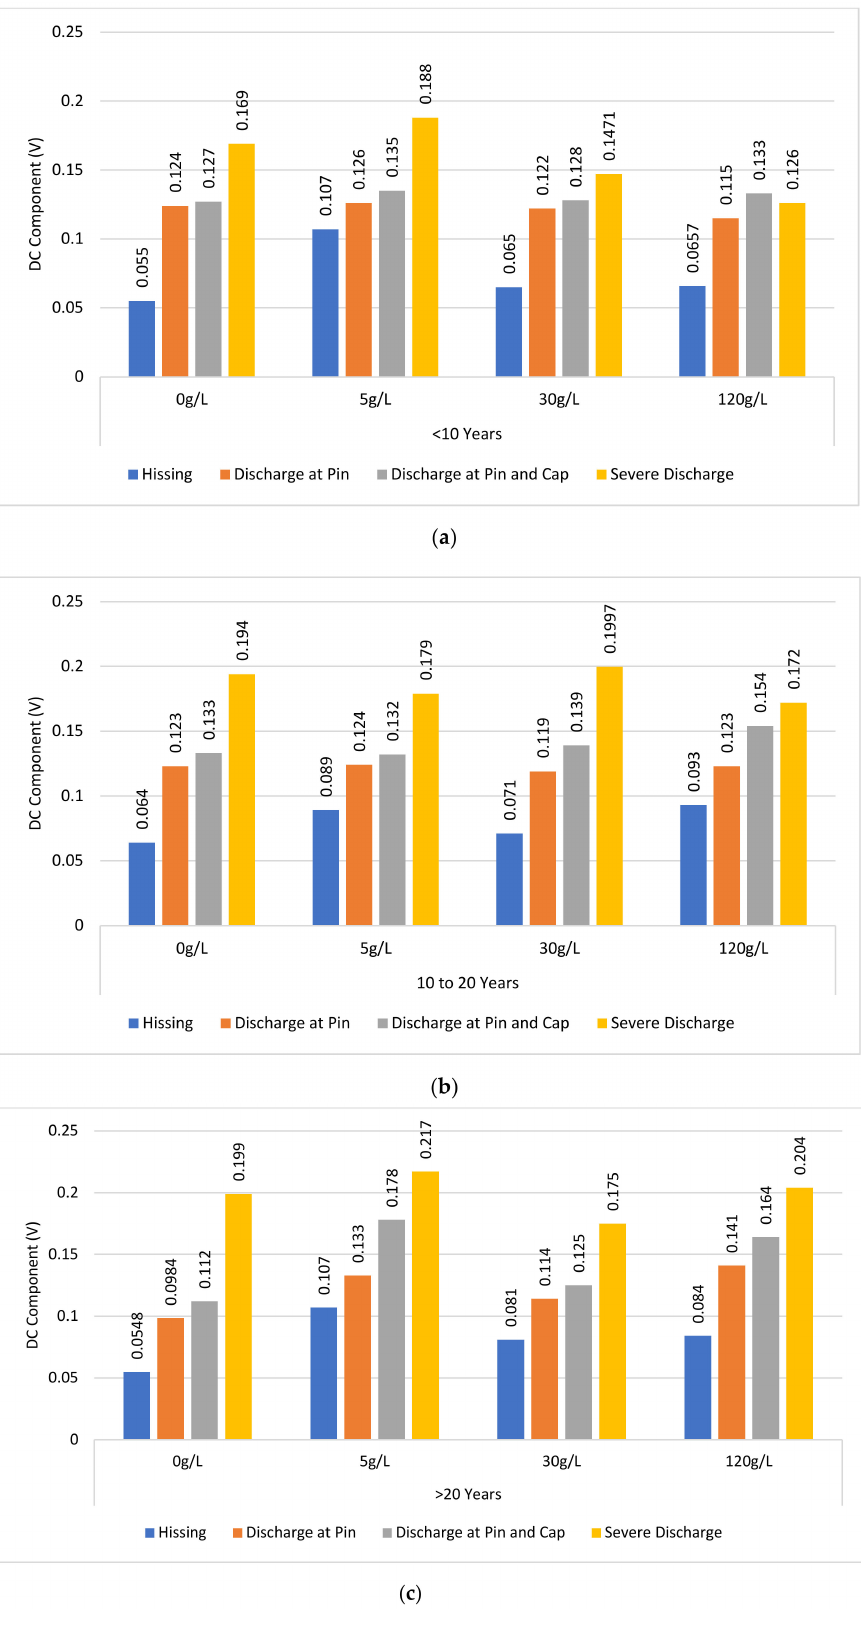
Figure 9. DC Component pattern for each level of contamination: ( a ) <10 years; ( b ) 10 to 20 years; ( c ) >20